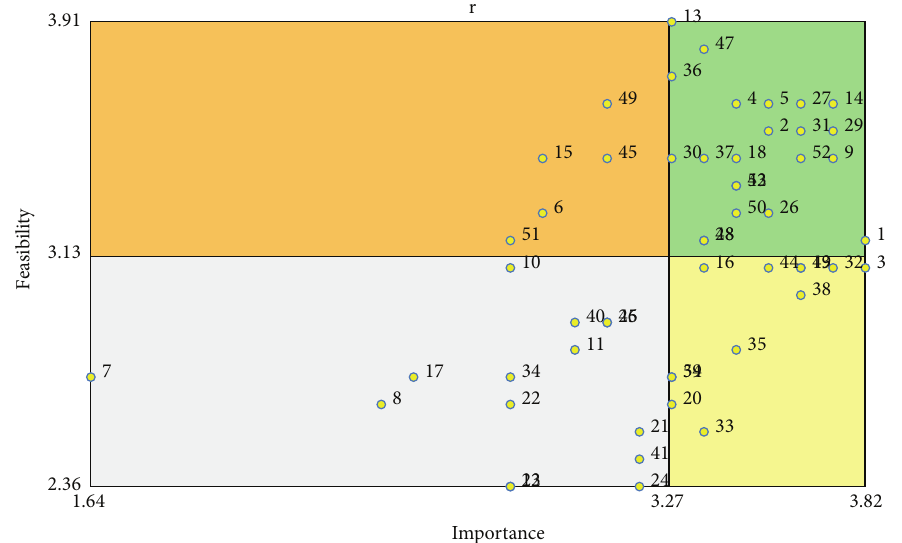
Figure 4: Go Zone analysis on importance and feasibility ratings by physicians. Items in the upper right quadrant represent those ranked highly in terms of importance and feasibility. Items in the lower right quadrant were ranked highly important, but not feasible. Each item number corresponds to the statement number in Table